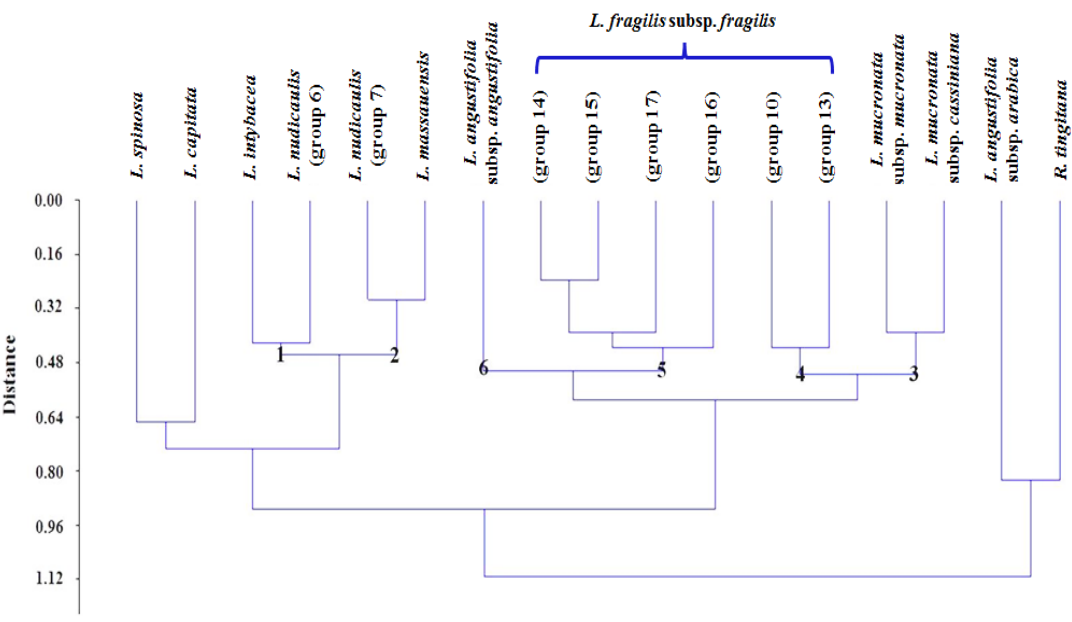
Figure 9. Dendrogram resulted from the UPGMA method of sorting for seventeen samples representing the outgroup Reichardia tingitana and 10 taxa of Launaea based on the achene and the pollen grain micromorphological attributes.